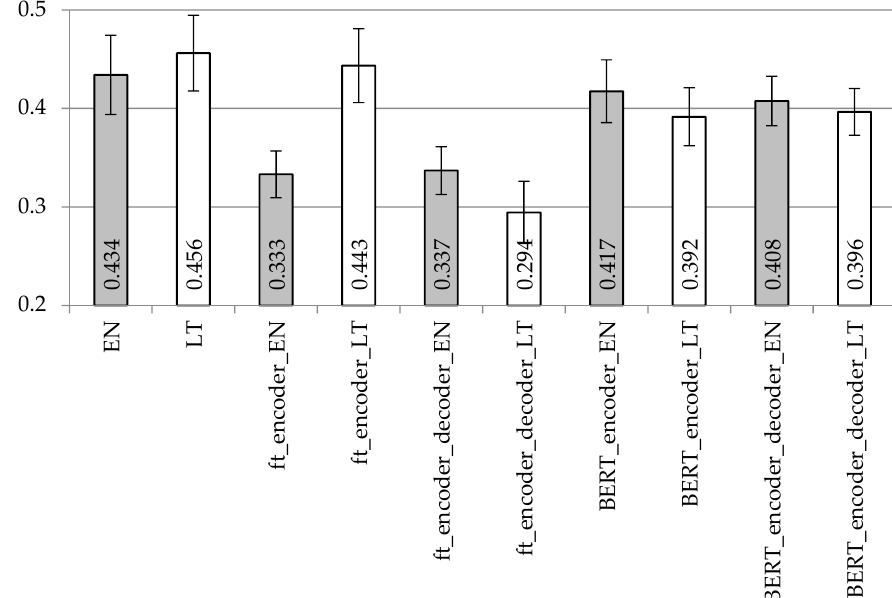
Figure 5. Averaged BLUE scores with confidence intervals using the LSTM encoder and decoder model with different vectorization types on the dataset with removed punctuation.